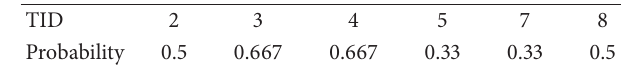
Table 2: Large itemsets.